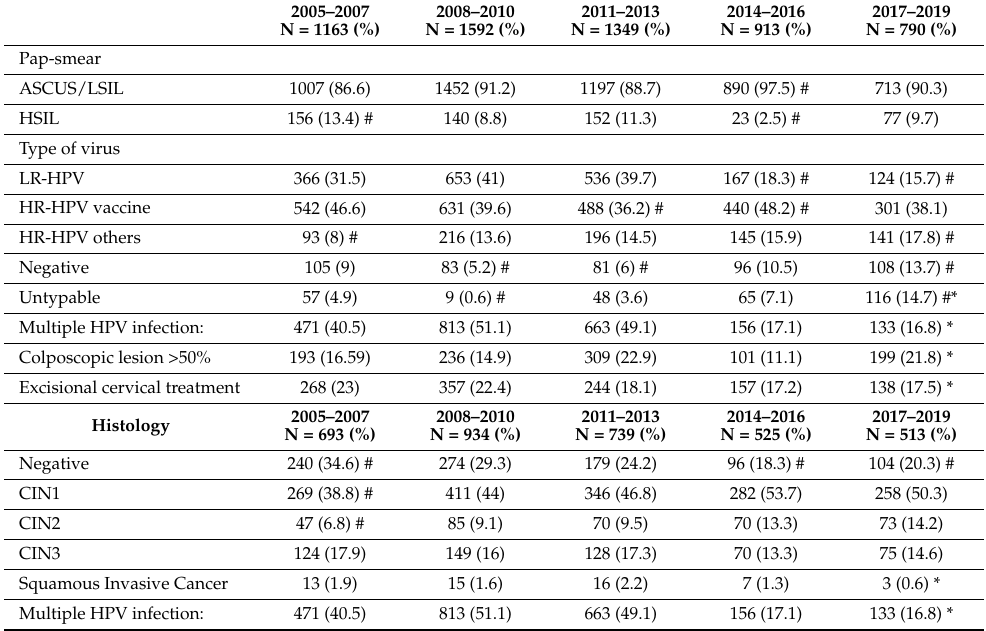
Table 2. Colposcopic, virological, cytological, and histological findings in the five periods under study.